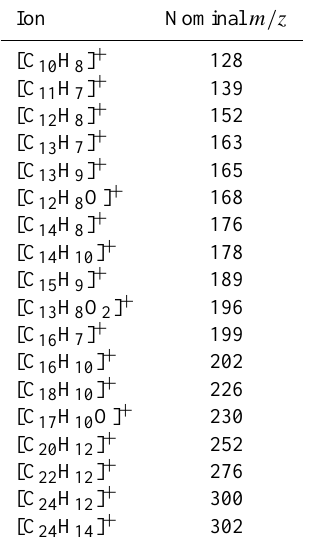
Table 2. PAH base ions included in the AMS analysis.